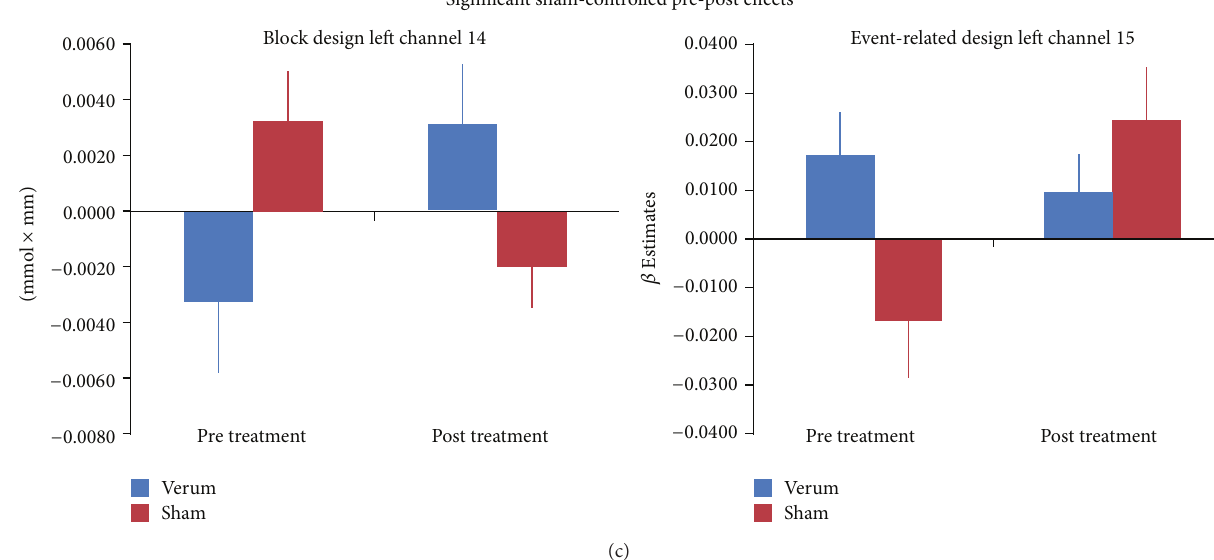
Figure 1: Localisation of light emitters (red squares) and detectors (blue squares) and measurement channels (numbers) for near-infrared spectroscopy (a). Sound-evoked activity for all subjects at baseline ( 𝑛 = 35 ; tinnitus patients and healthy controls) as indicated by brain oxygenation (b). Channels with significant group by time interaction effects